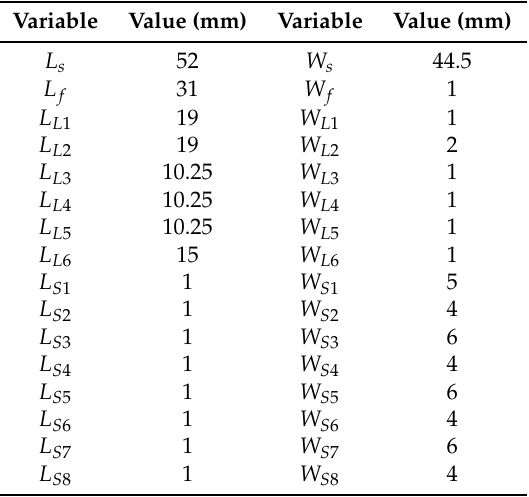
Table 1. Variable values for the original IFA meander line antenna in [30].